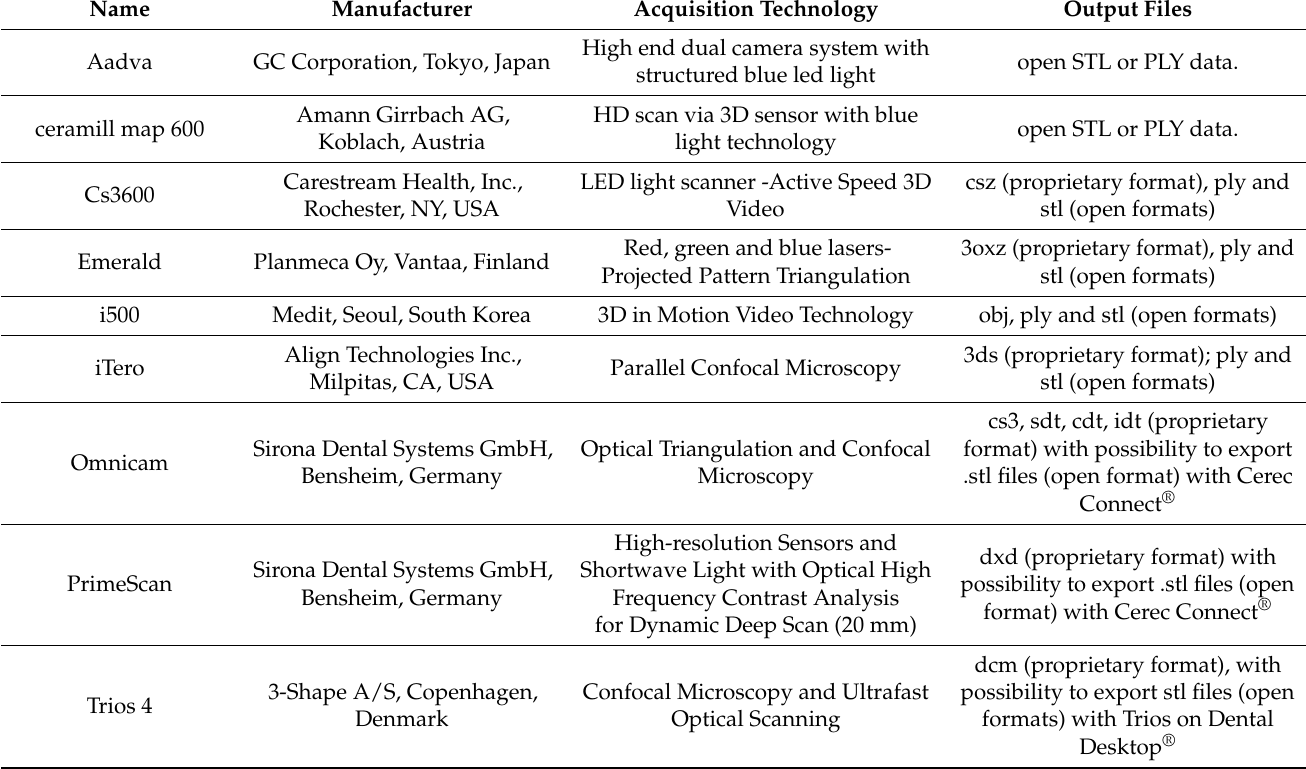
Table 1. List of intraoral and laboratory